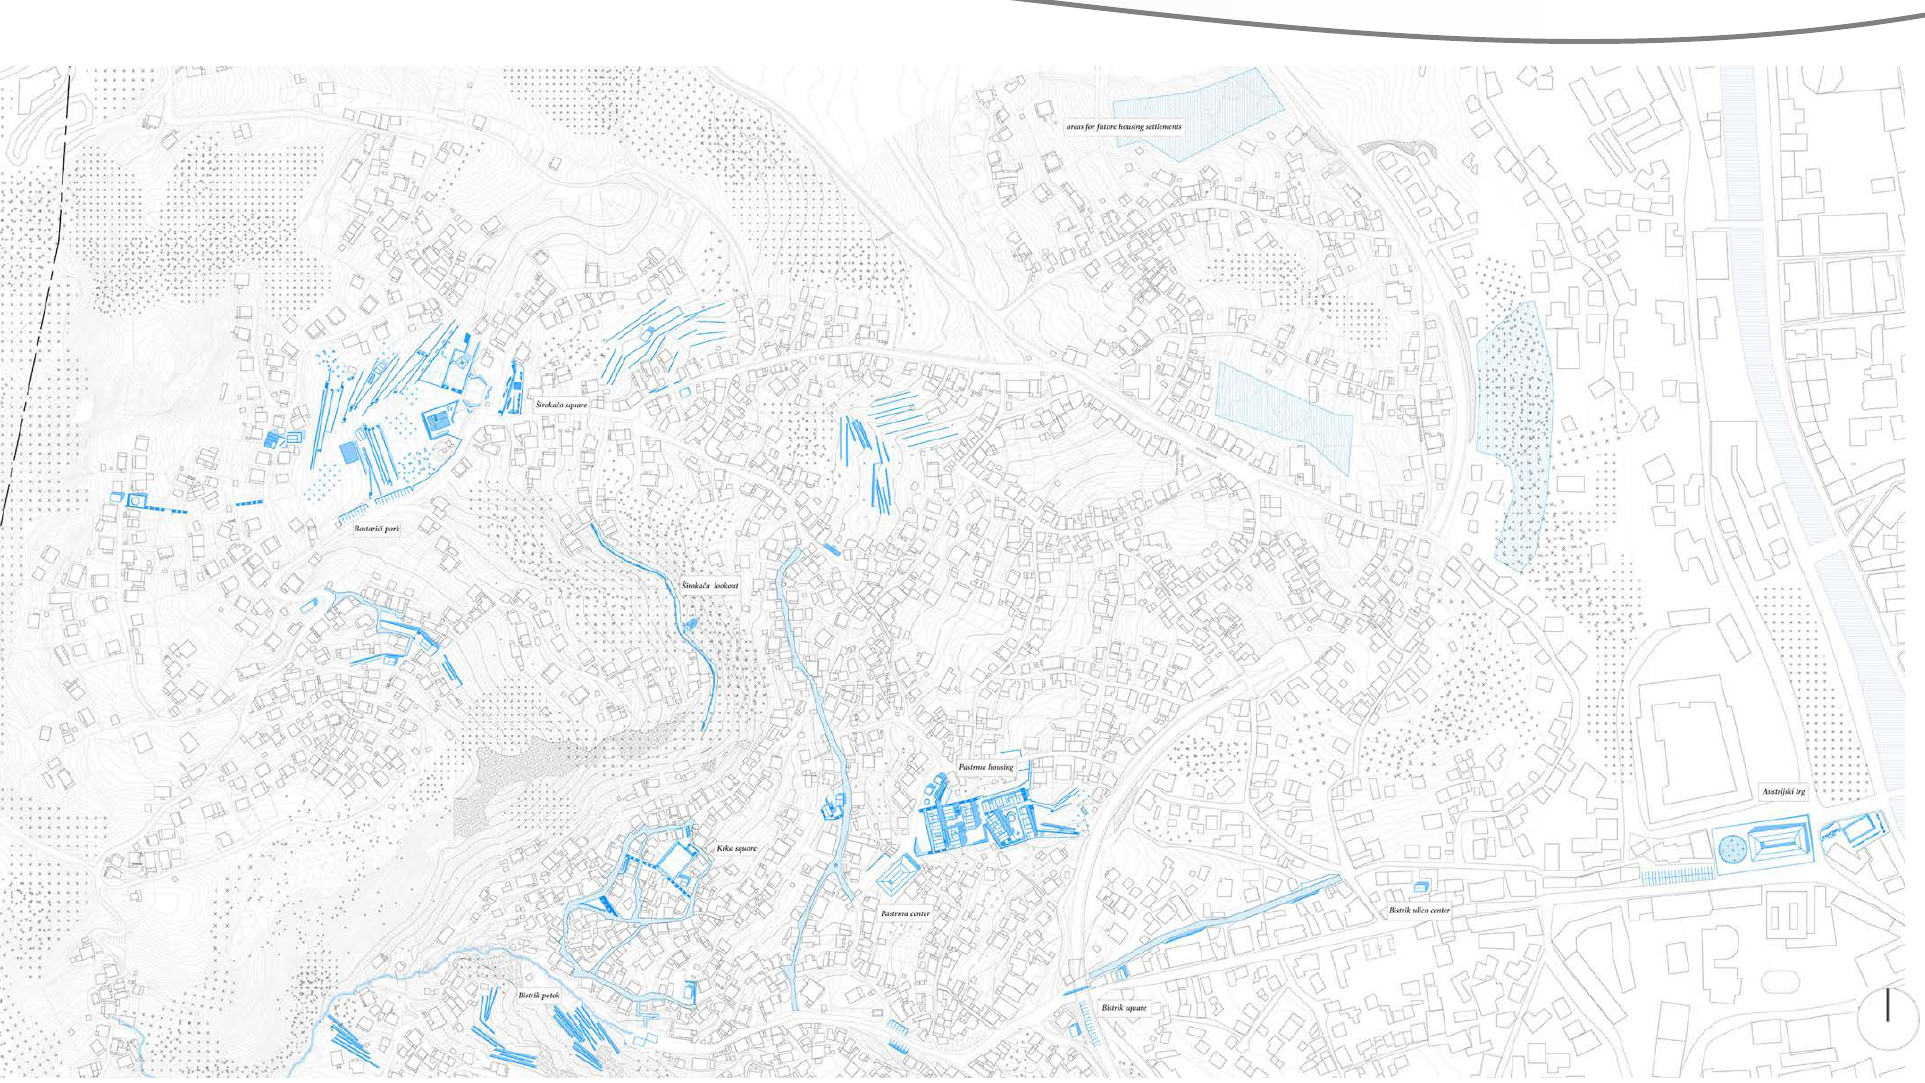
Figure 11: Extract of masterplan for Širokača showing the whole pathway of facilities from Stari Grad to the